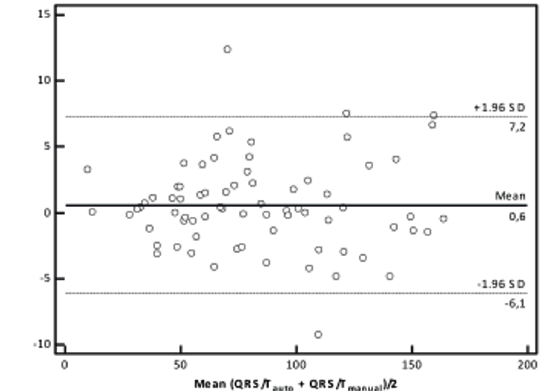
Figure 1. Bland and Altman plots for agreement between auto- mated and manual measurements of QRS/T